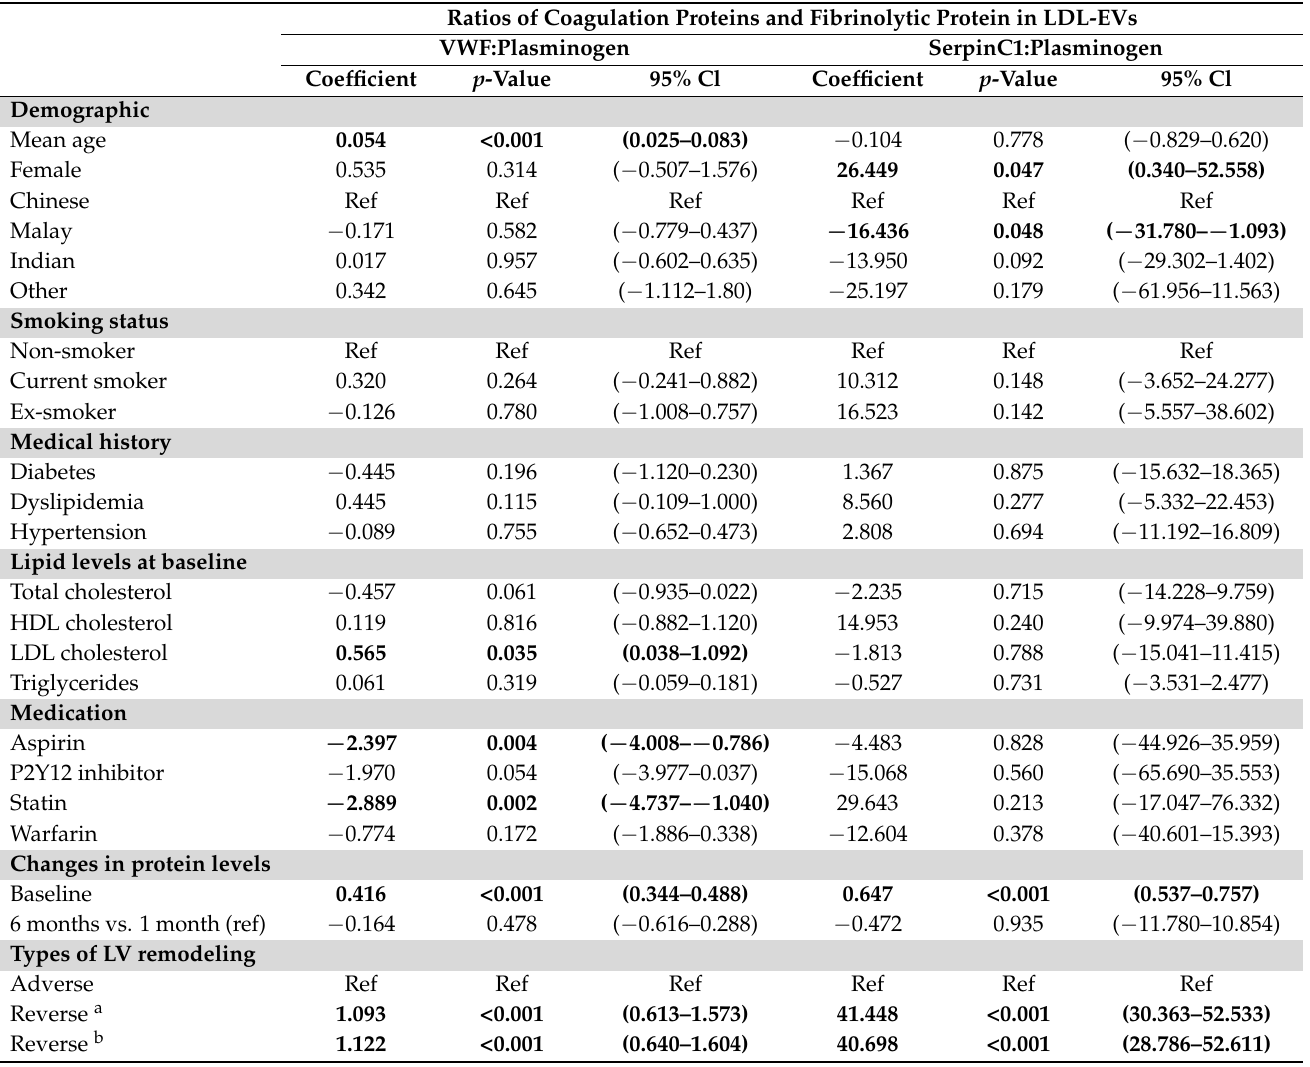
Table 3. ML-SEM modeling for LDL-EV